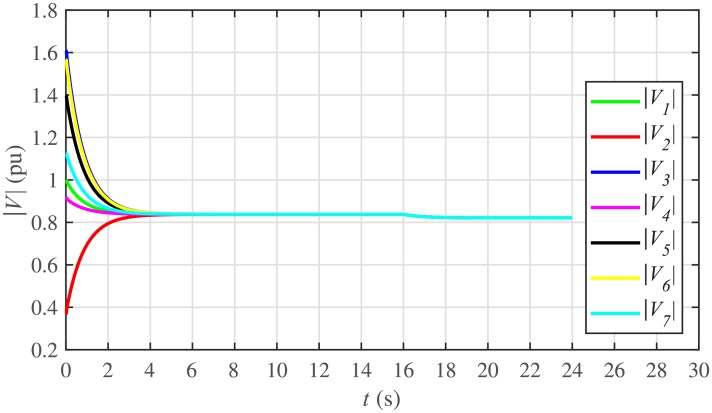
Voltage regulation under case 5. [27].